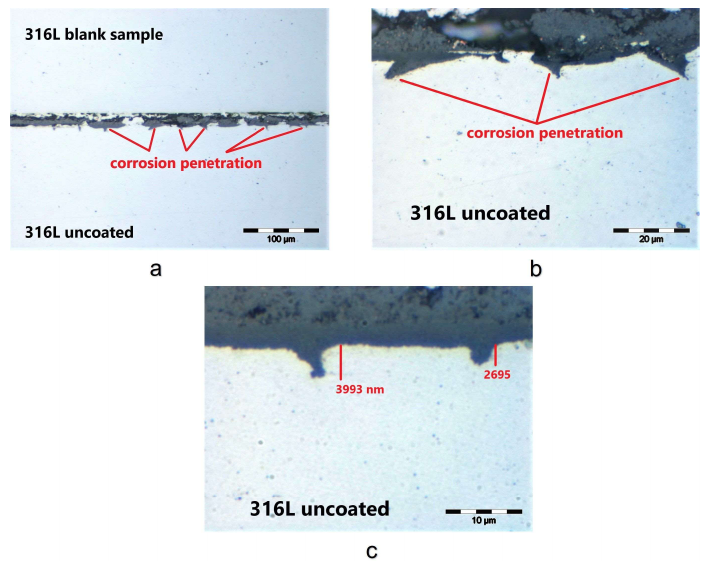
Figure 12. Cross section of an AISI 316L uncoated specimen after being tested for 1000 h in liquid lead at different magnifications: 200 × ( a ), 1000 × ( b ), and 2000 × ( c ).